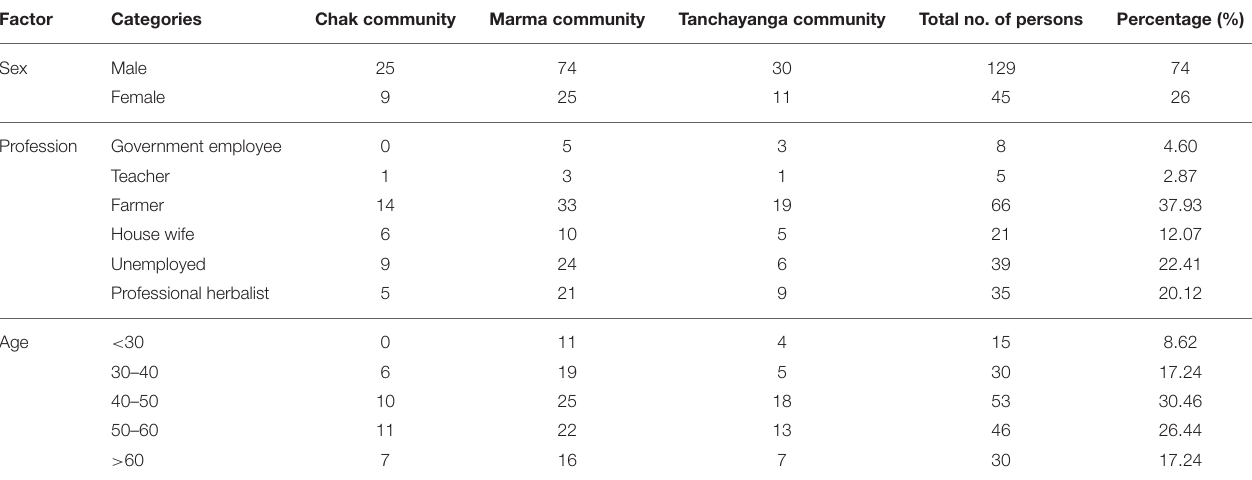
TABLE 2 | Demographic characteristics of